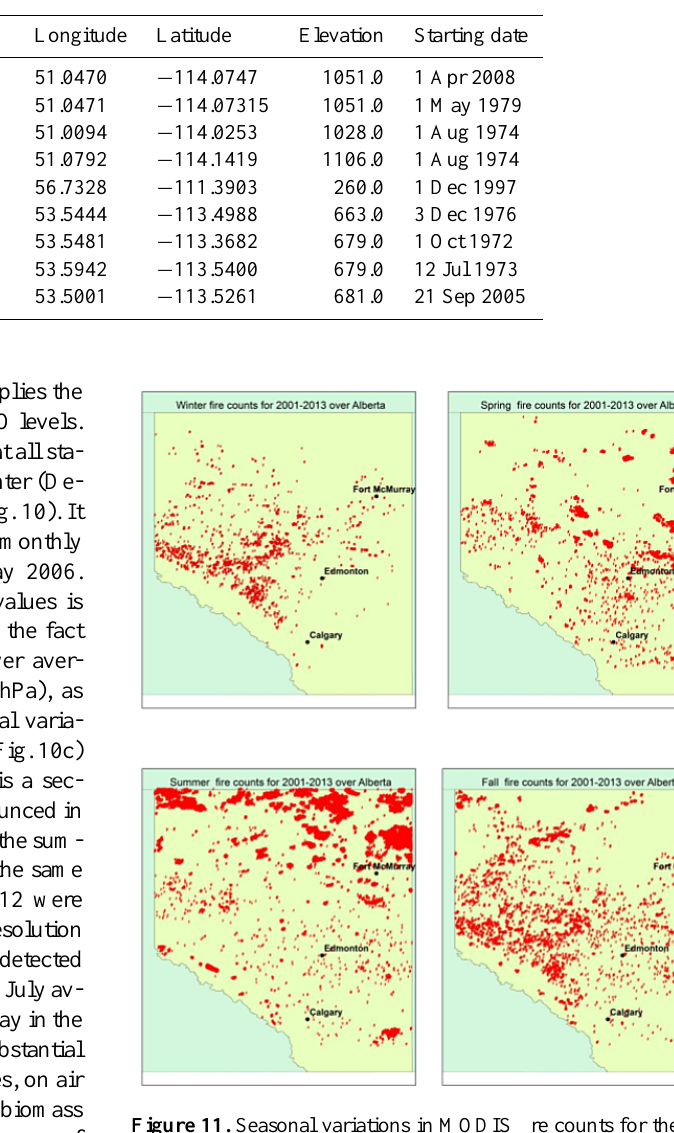
Table 2. Location, elevation and starting date of selected CASA monitoring stations.